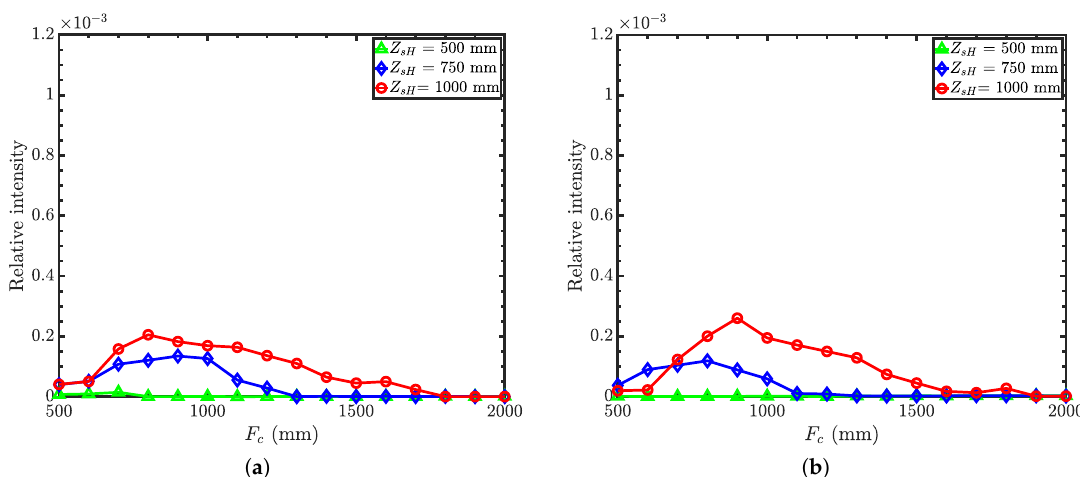
Figure 11. Relative intensity of the Wolter III microscope as a function of condenser focal length with an objective focal length of 500 mm, 750 mm, and 1000 mm. ( a ) Guide-to-condenser distance = 500 mm; ( b ) guide-to-condenser distance = 1000 mm. Here, the working distance is Z sH . The vertical scale is the same as in Figures 4 and 8 for the ease of comparison.